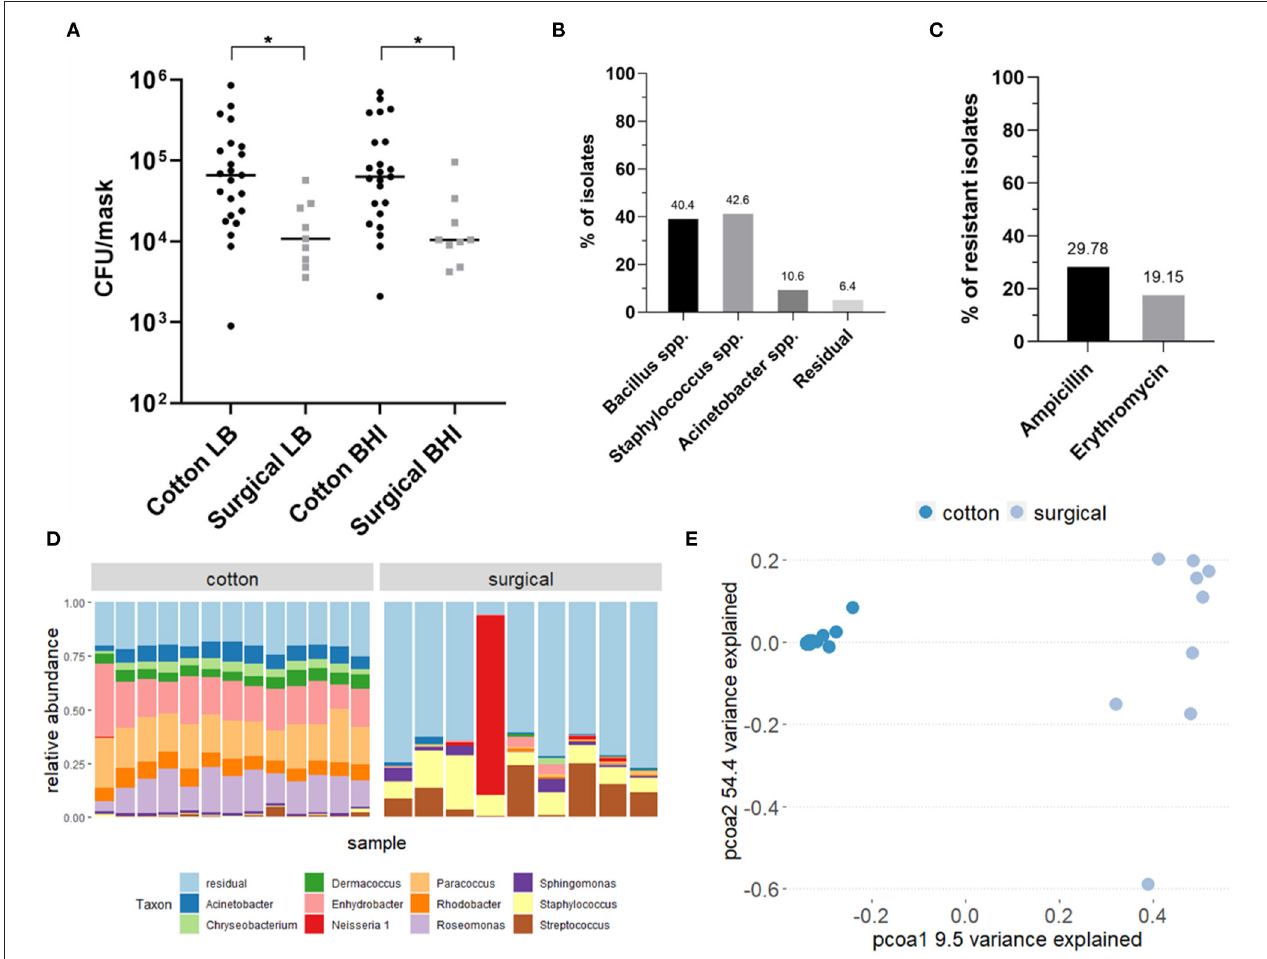
FIGURE 2 | Analysis of the bacterial composition of cotton and surgical face masks after 4h of wearing. (A) Mask bacterial load quantified via culturing on LB and BHI agar plates after 4h of wearing. Data shown the mean CFU/mask (calculated to represent the whole face mask) for both growth media and mask types. Statistics were performed using ANOVA with Kruskal-Wallis multiple comparisons test * p < 0.05. (B) Identification of selected bacterial isolates cultured from both types of face masks through Sanger sequencing of the V4 region of the 16S rRNA gene. (C) Percentages of isolates cultured from both types of face masks that showed resistance to the antibiotics ampicillin and erythromycin. (D) Taxonomic bacterial community composition on the face masks at genus-level where each bar represents a participant, analyzed via 16S rRNA amplicon sequencing. (E) Principal Coordinates Analysis (PCoA) plot distributing the samples according to beta-diversity (Bray-Curtis distance). Samples are colored by type of mask. LB, Luria-Bertani broth; BHI, Brain Heart Infusion; AB, antibiotic; C, cotton face mask; S, surgical face mask.